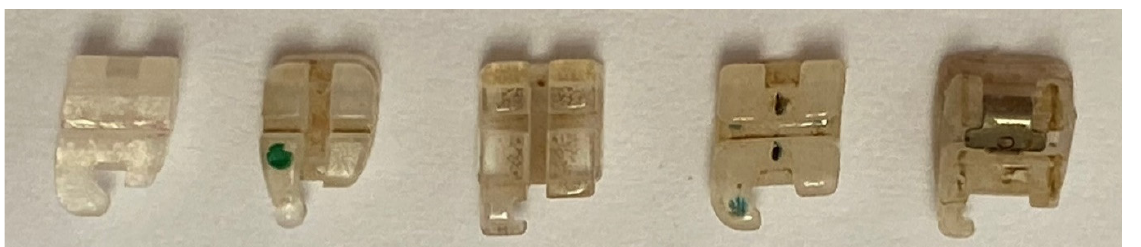
Figure 2. 20/40™ Brackets, Vapor™, DynaFlex ® , ClearViz + Mini and QuicKlear ® III ® brackets after 14 days of immersion in the coffee